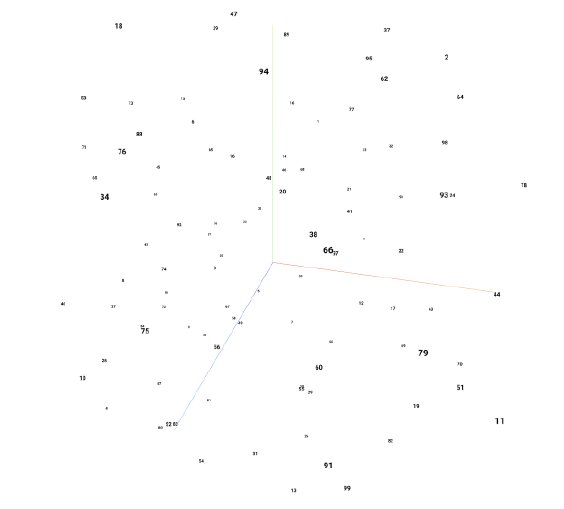
Figure 10. The demonstration of the UMAP 50 neighbors’